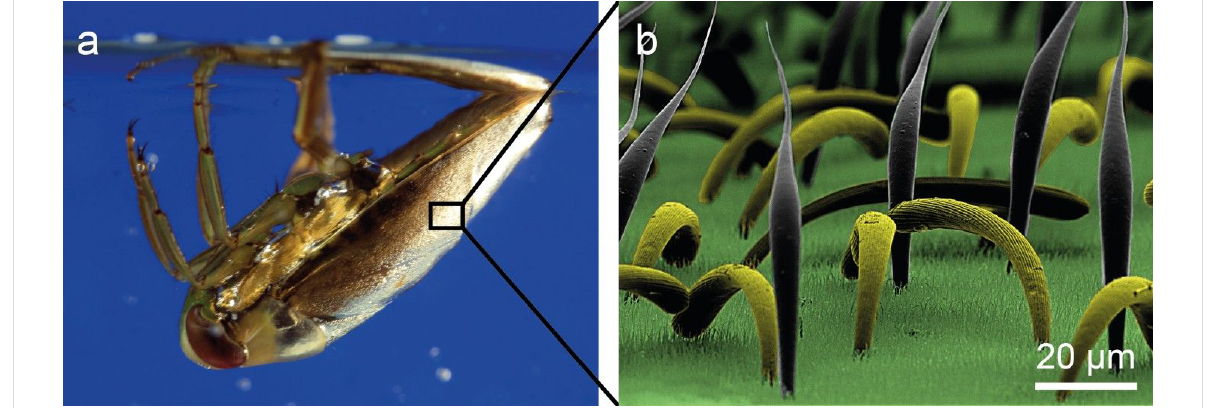
Figure 1: a) The backswimmer N. glauca . The silvery shine on the surface of the hemelytra is caused by the total reflection of light at the air–water interface. b) Colored SEM-image of the surface of the hemelytra of a backswimmer. Two types of setae (“clubs” are yellow and “pins” are grey) and a “carpet” of short, densely packed “microtrichia” stabilize the air layer and assure stable air retention. Source: (b) modified after